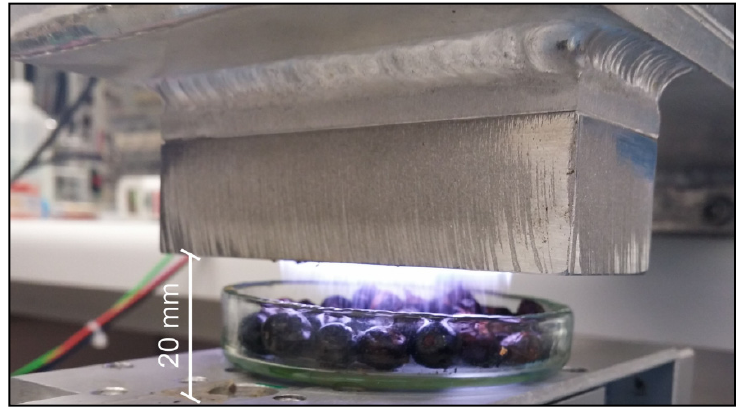
Figure 2. Photo of plasma treatment of juniper berries.